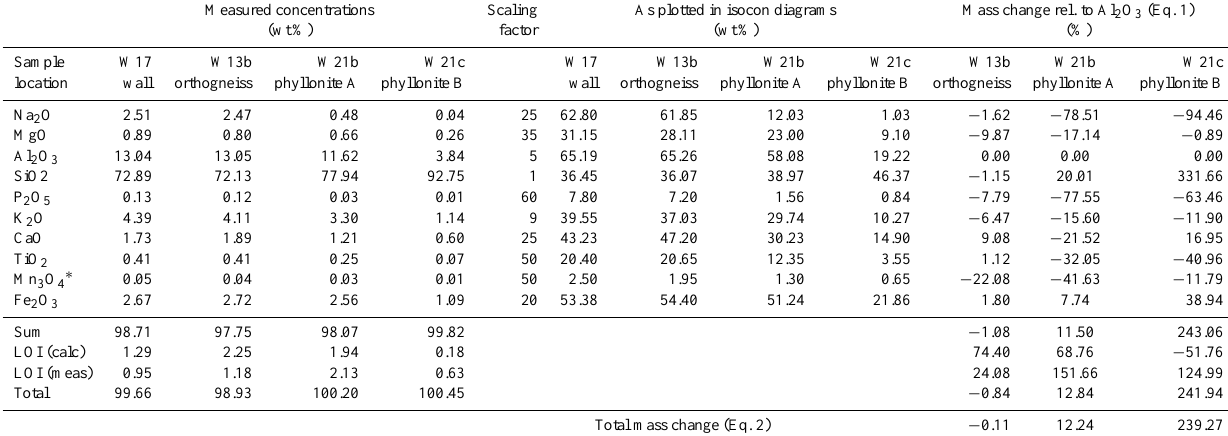
Table A1. Whole-rock geochemical data. Major element concentrations and mass balance calculations of the selected samples from wall rock, orthogneiss, phyllonite A and phyllonite B. Detection error for the measurements is given in Table A1.